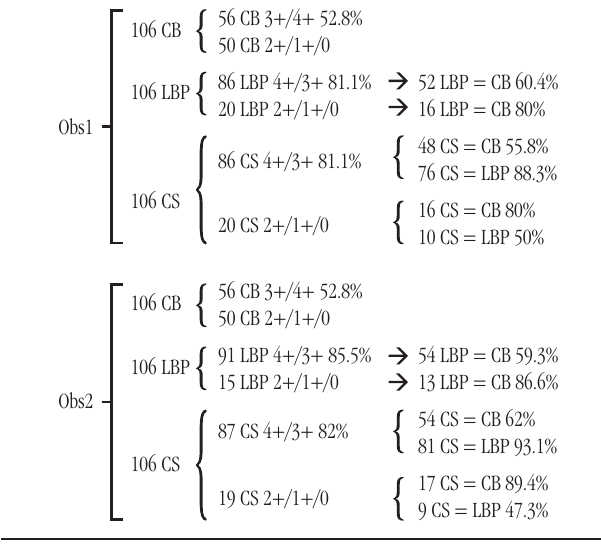
figurE 1 − Flowchart showing evaluation results of 106 cases of FNAB of thyroid nodule in diagnostic routine, including CS, LBP, and